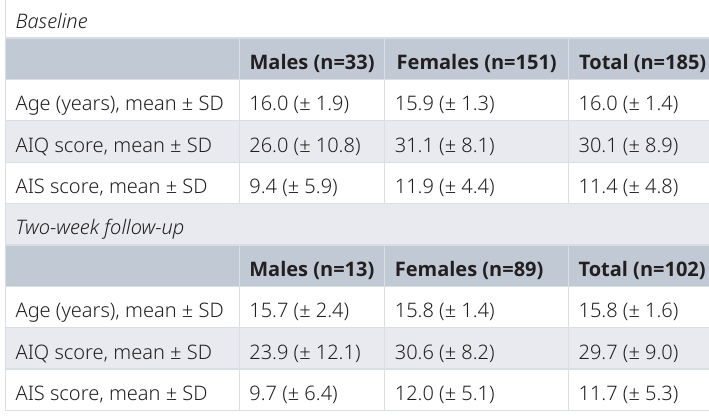
Table 3. Descriptive characteristics at baseline and two-week